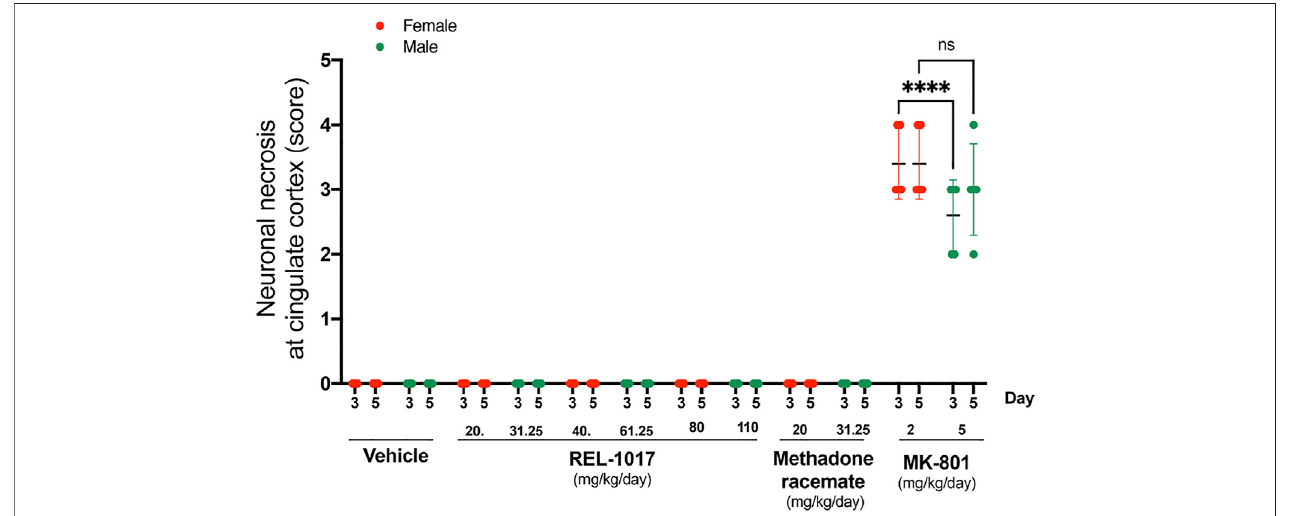
FIGURE 4 | No sex dysmorphism was observed in the REL-1017 effect on cingulate neuronal necrosis. Separate quanti fi cation of neuronal necrosis in female and male groups. No differences in neuronal necrosis quanti fi cation were observed between female and male REL-1017 treated rats. As expected, we observed a major severity of necrosis in female rats treated with MK-801 ( p < 0.0001 at Day